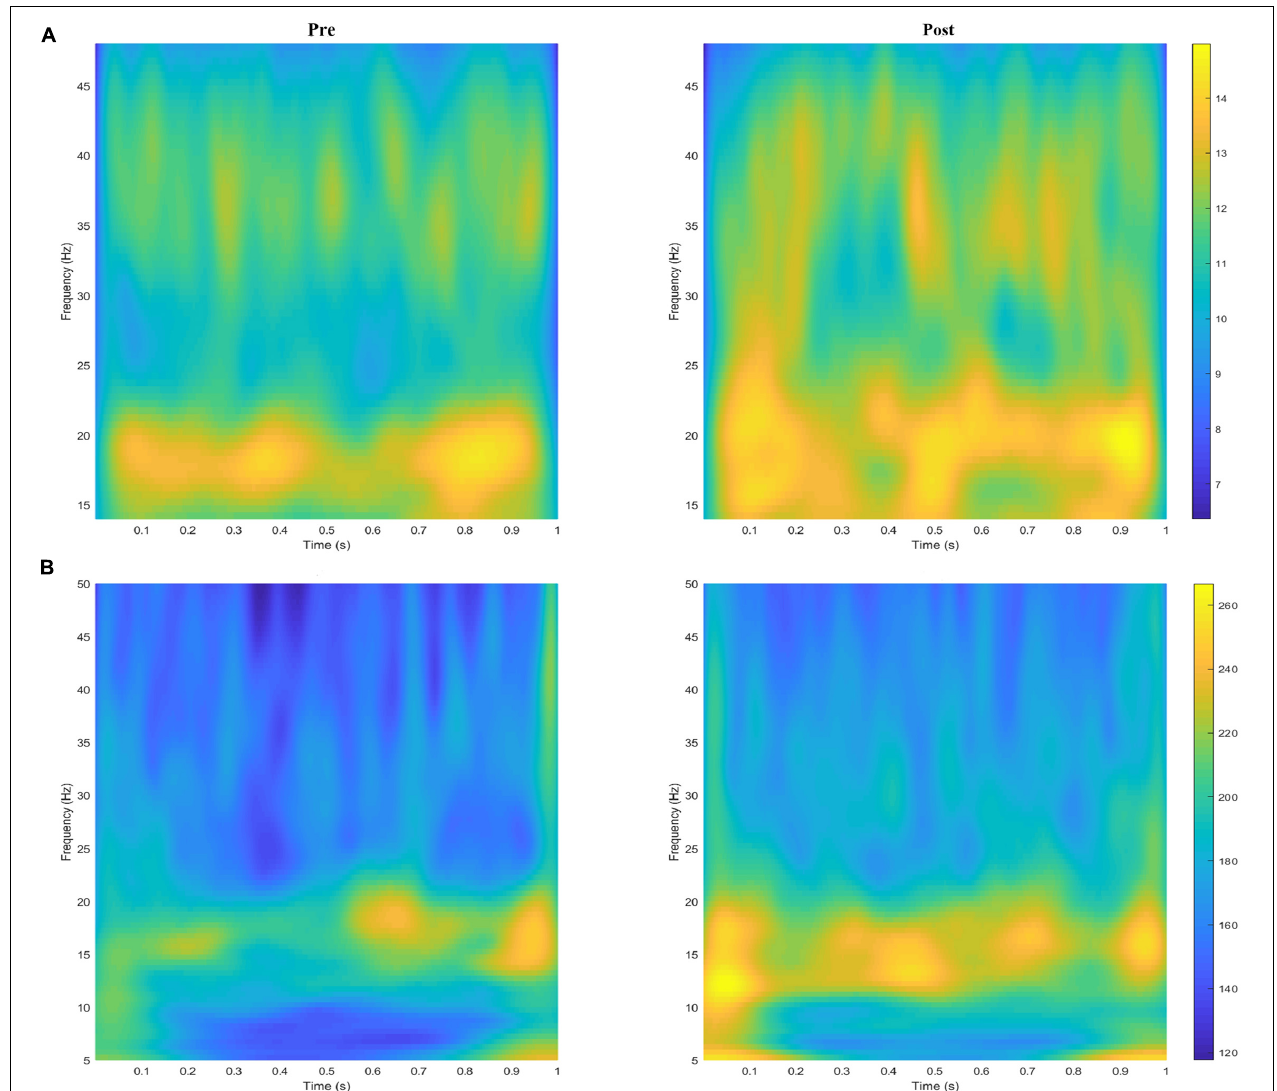
FIGURE 4 | The grand averages of the wavelet time–frequency maps for (A) EEG (C3) and (B) sEMG (FDS) during the pre- and post-fatigue